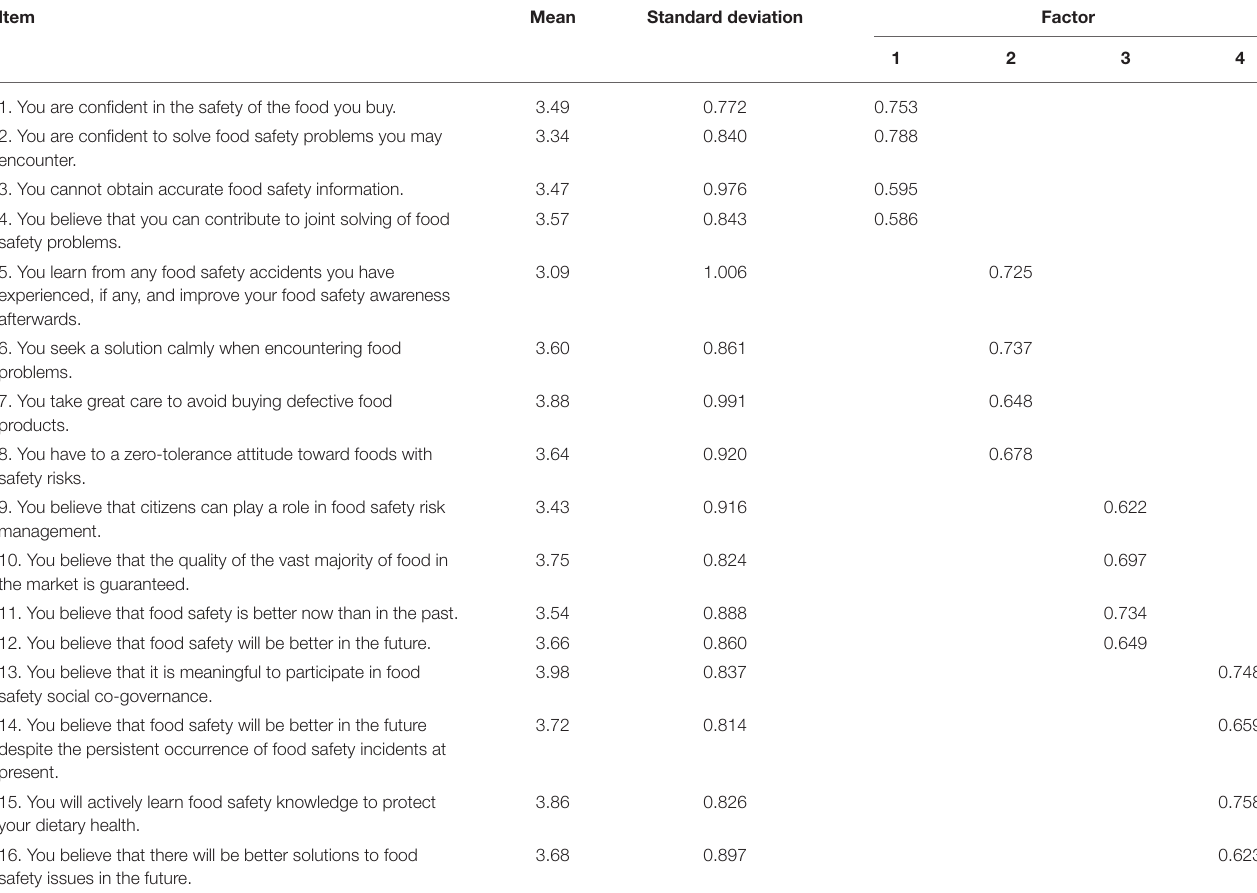
TABLE 6 | Rotated factor loading matrix. Item